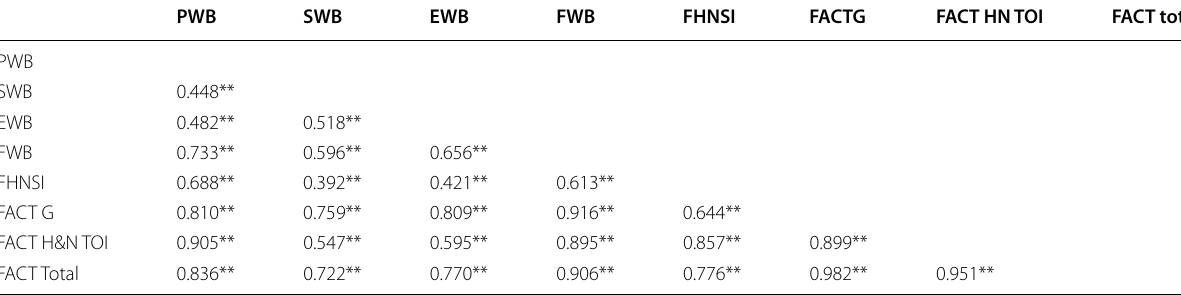
** Correlation significant at 0.01 level, * Correlation significant at 0.05